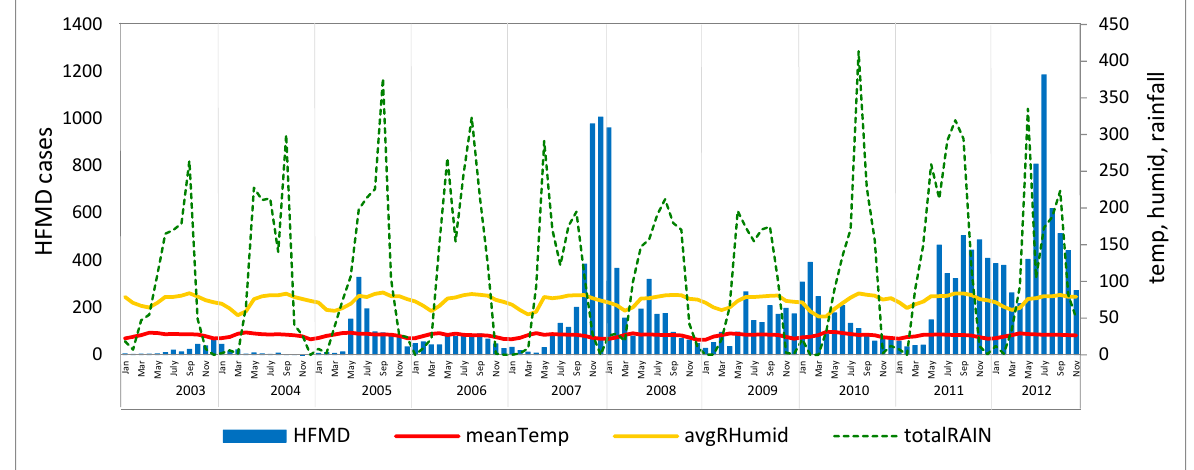
Figure 5. HFMD case counts per month from 2003 to 2012 related to climatic factors.